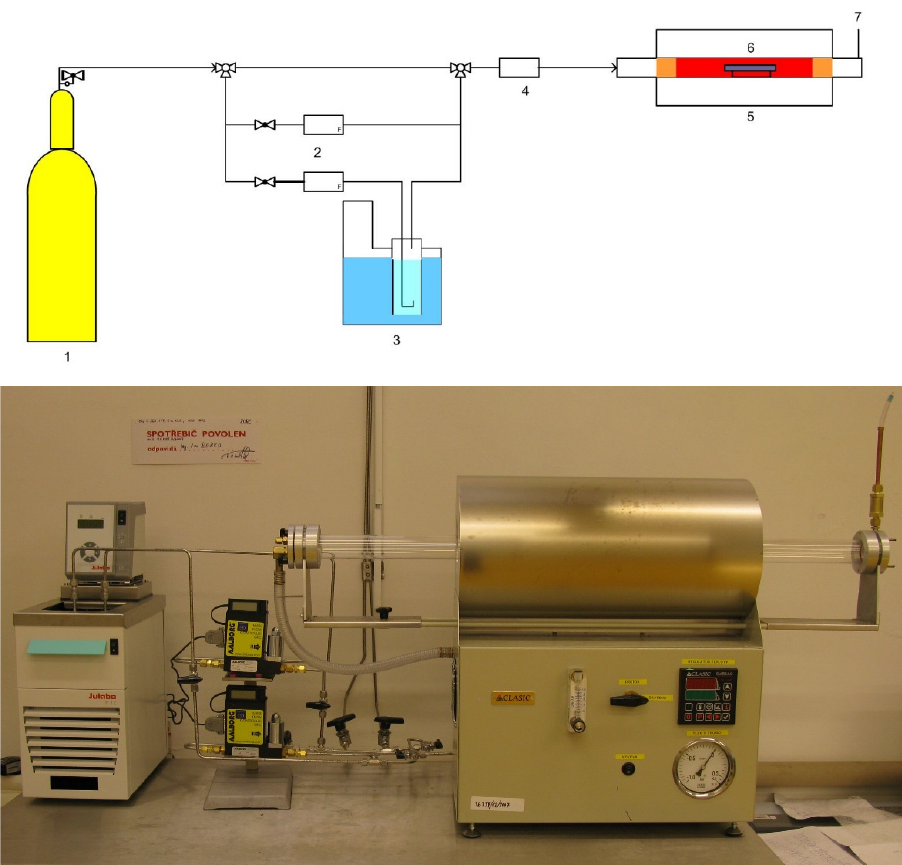
Figure 1. Scheme ( top ) of high-temperature helium in the test system and the real facility ( bottom ): 1. Gas cylinder; 2. Two mass flow controllers; 3. Unit for controlled gas humidification; 4. Moisture analyzer (Hygrometer); 5. Tube furnace with a metal retort; 6. Sample holder; 7. Gas